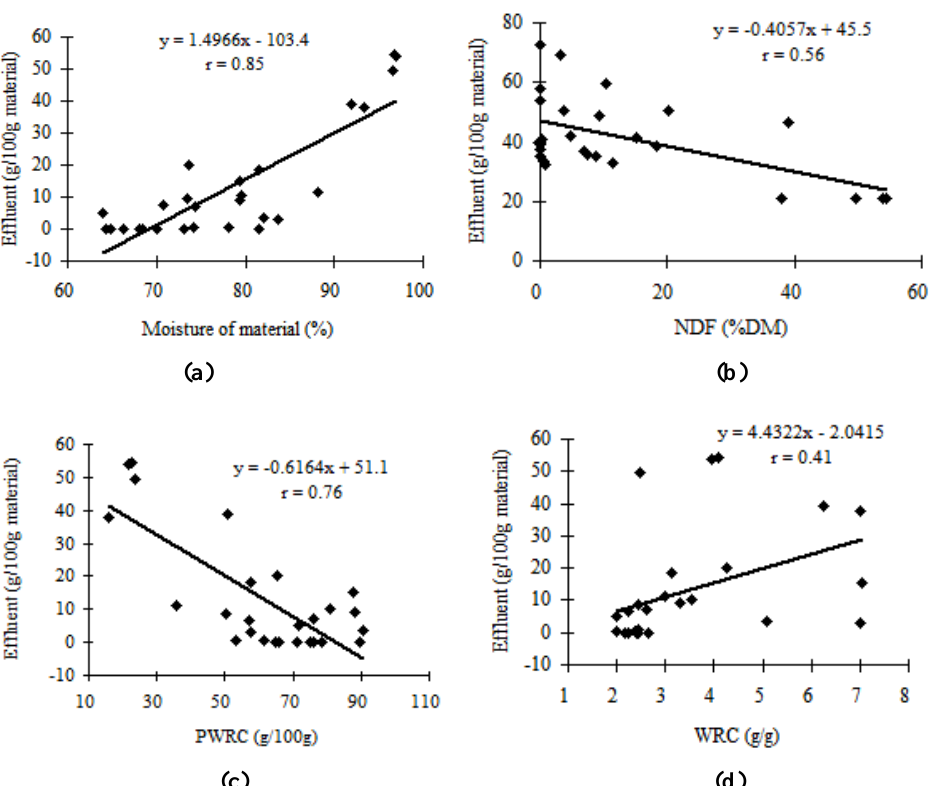
Figure 1. Relationships between moisture (a), NDF (b), PWRC (c), and WRC (d) of some HMBF (n = 27) and effluent output from their silages (n =